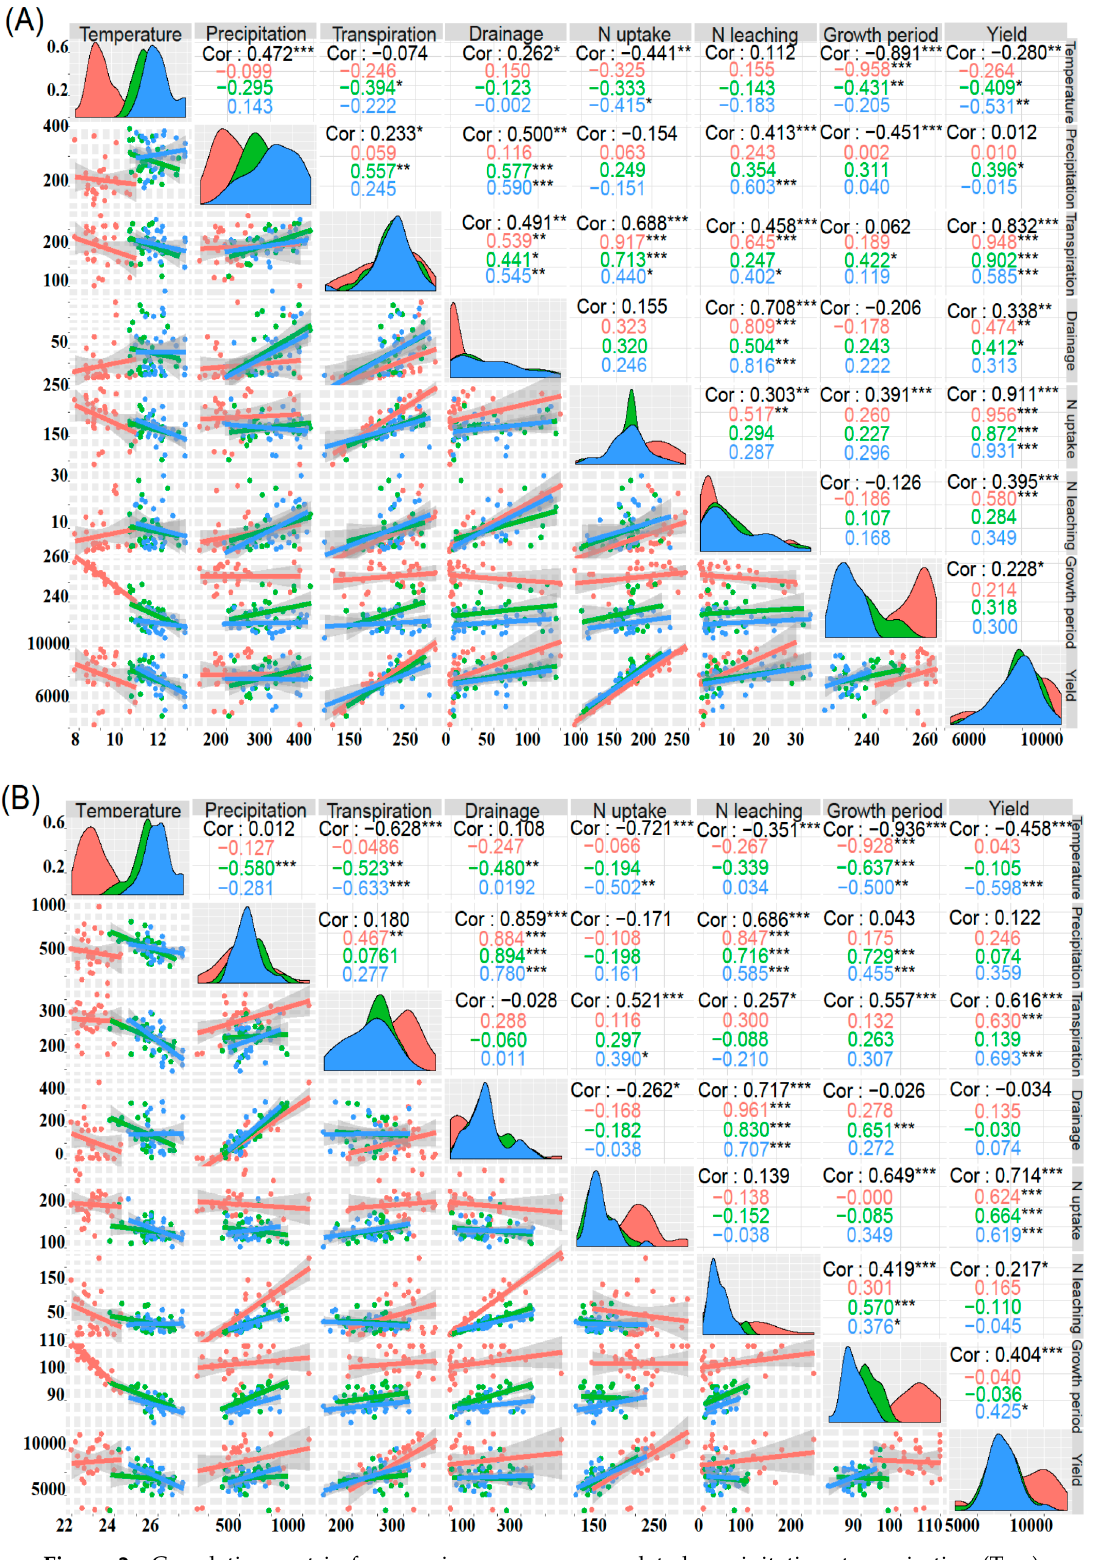
Figure 2. Correlation matrix for growing season accumulated precipitation, transpiration (T a ), soil water drainage, crop N uptake, soil nitrate leaching, and yield for winter wheat ( A ) and summer maize ( B ) based on the mean of all climate scenarios of baseline (red), RCP4.5 (green), RCP8.5 (blue) climate scenarios, respectively. Note: *** Significant at the 0.001 probability level, ** Significant at the 0.01 probability level, * Significant at the 0.05 probability level.